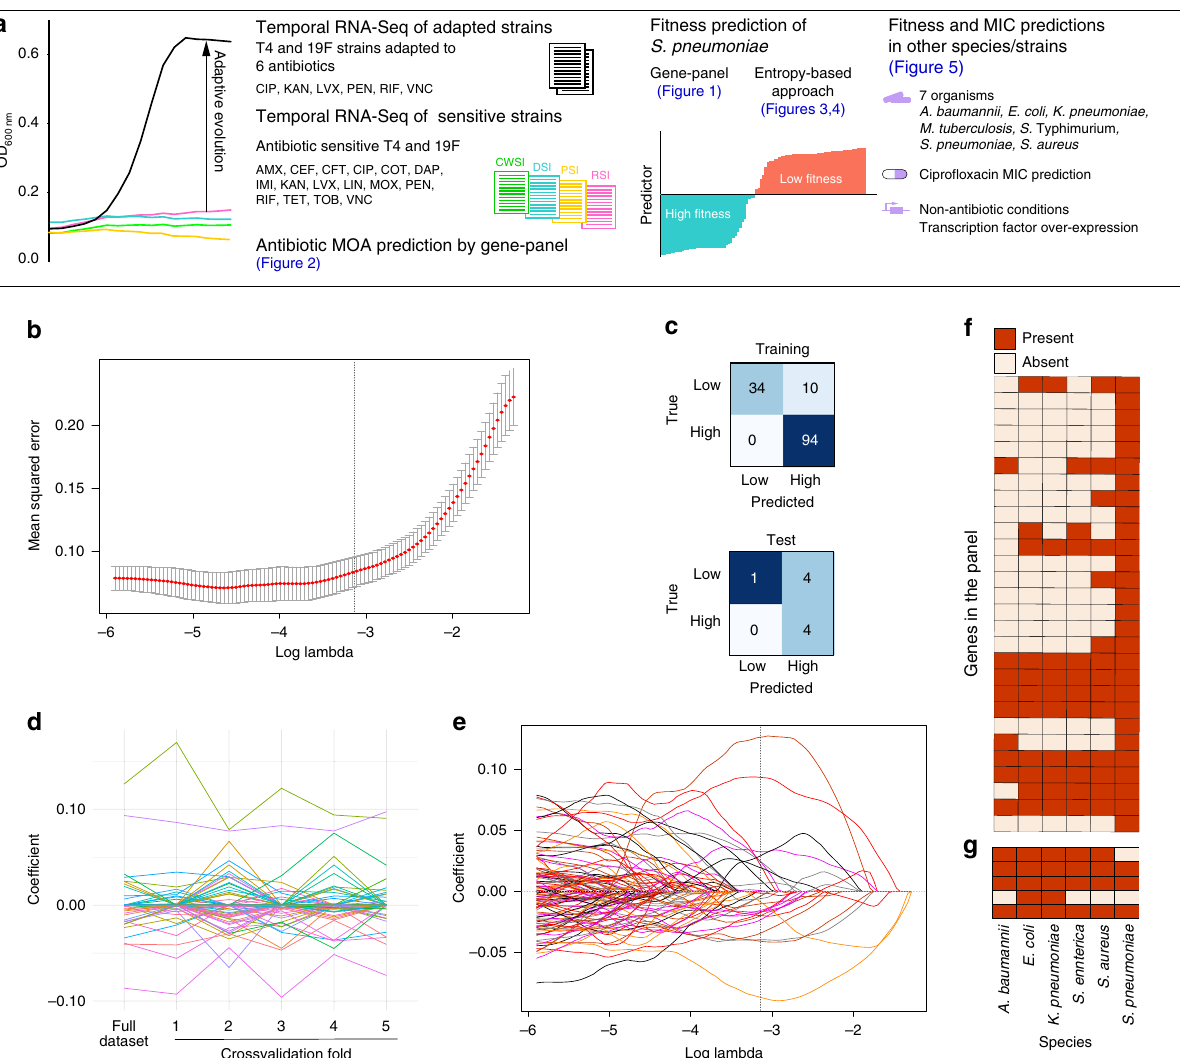
Fig. 1 Gene panel-based fi tness predictions of S. pneumoniae under antibiotic and nutrient stress. a Project setup and overview. Wildtype and adapted strains of S. pneumoniae are exposed to multiple antibiotics, belonging to four different classes, and their fi tness outcomes in each condition is determined by growth curves. Temporal RNA-Seq data is used to train models that predict the MOA of an antibiotic, and the fi tness outcome of a strain using gene- panel approaches. The concept of entropy is developed expanding predictions to MIC and fi tness for other strains and species in the presence of antibiotics and in non-antibiotic conditions. CWSI cell wall synthesis inhibitors: AMX amoxicillin, CEF cefepime, CFT ceftriaxone, IMI imipenem, PEN penicillin, VNC vancomycin; DSI DNA synthesis inhibitors: CIP cipro fl oxacin, COT cotrimoxazole, LVX levo fl oxacin, MOX moxi fl oxacin; RSI RNA synthesis inhibitor: RIF rifampicin; PSI protein synthesis inhibitors: KAN kanamycin, LIN linezolid, TET tetracycline, TOB tobramycin; DAP daptomycin (a membrane disruptor). b A gene-panel for fi tness prediction is generated by a regularized logistic regression model fi t on differential expression data from the training set. The selected value of λ = 0.0428 is shown as a dashed line, resulting in 28 genes in this panel. Red points and error bars represent mean ± standard deviation of error across n = 5 crossvalidation folds. c Prediction performance of the fi tness gene-panel is shown as confusion matrices for the training (top) and test (bottom) datasets. The gene-panel generates 10 and 4 false positives, and an overall accuracy of 0.93 and 0.77 in the training and test data sets respectively. d Coef fi cients of individual features (i.e., genes) are plotted for the model trained on the full dataset, and fi ve crossvalidation training folds, where 20% of the data is omitted during model fi tting. The gene-panel is highly affected by training data, indicated by many genes having nonzero coef fi cients on some folds, but not others. Only 5 out of the 28 genes in the fi tness gene-panel are maintained as predictors in the regression models across all folds. e Each gene ’ s coef fi cient is plotted as an individual line, against varying values of λ . The gene panel is highly affected by λ , indicated by the nonmonotonic increase or decrease in the coef fi cient in each gene. In fact, there are many genes that have nonzero coef fi cients only for a small range of λ . Dashed line depicts the selected value of λ as in ( b ). f The presence and absence of each of the 28 genes in the S. pneumoniae fi tness panel is highly variable across 5 Gram-positive and Gram-negative species. g A published E. coli cipro fl oxacin sensitivity panel 11 also suffers from a lack of conservation across the same group of species. Gene identi fi ers can be found in Supplementary Table